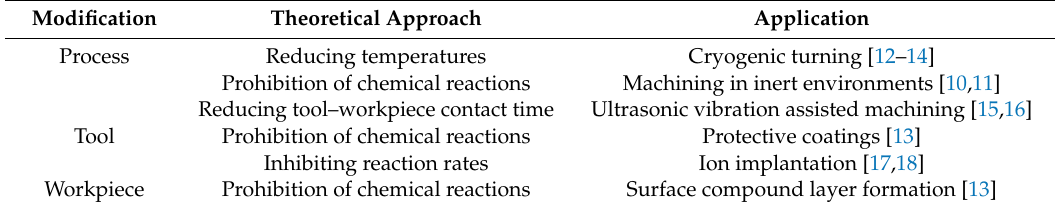
Table 1. Diamond tool wear mitigation techniques to machine ferrous